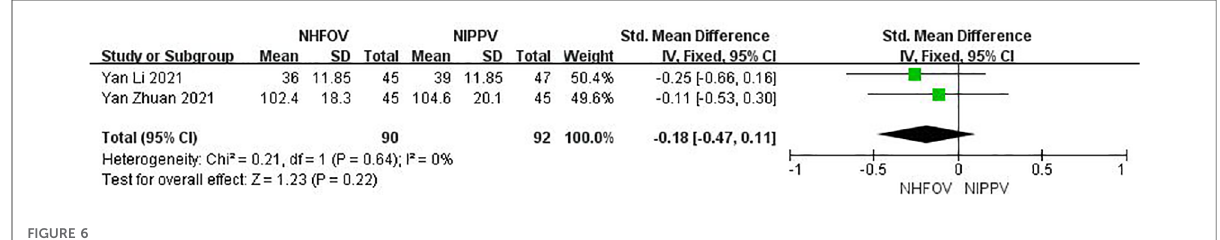
FIGURE 6 Results of the meta-analysis of length of hospital